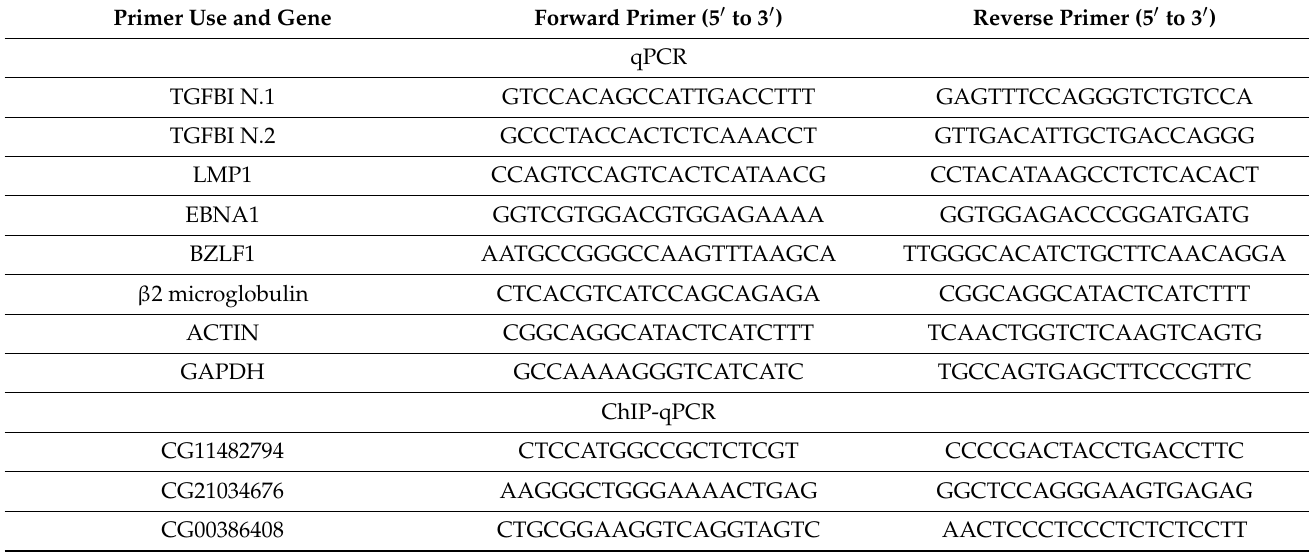
Table 1. Primers used for qPCR and ChIP-qPCR (sequence of primers 5 (cid:48) –3 (cid:48)